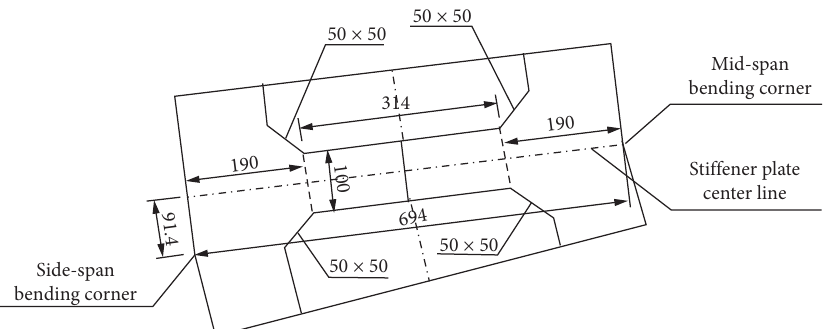
Figure 11: Elevation of a stiffening plate for the bending corner of the main tower.